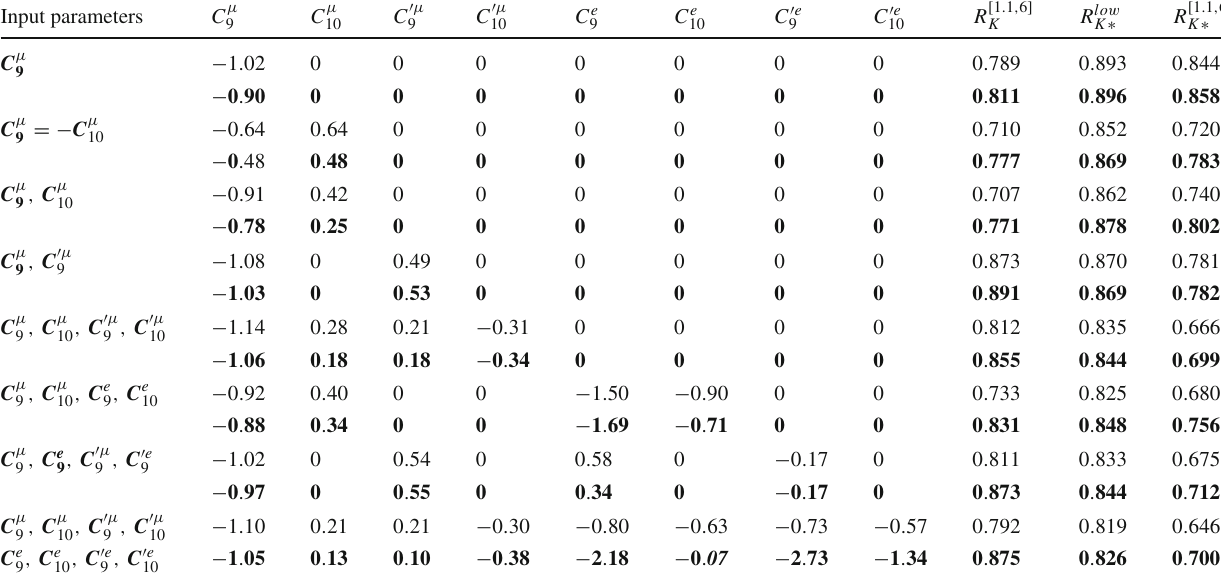
Table 4 Wilson coefficients at the best-fit points, as well as the values there of R K and R K ∗ . Bold highlighted rows correspond to the new data, while the unbolded ones show the previous determinations Input